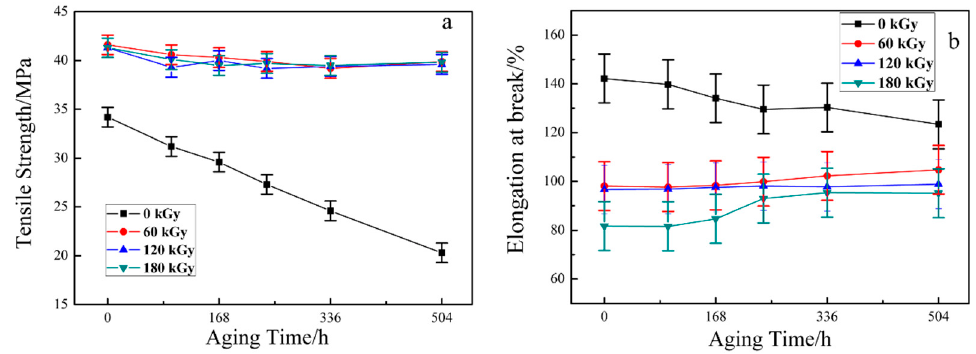
Figure 7. The effect of aging time on the mechanical properties of ETFE at various doses. ( a ) tensile strengthen; ( b ) elongation at break